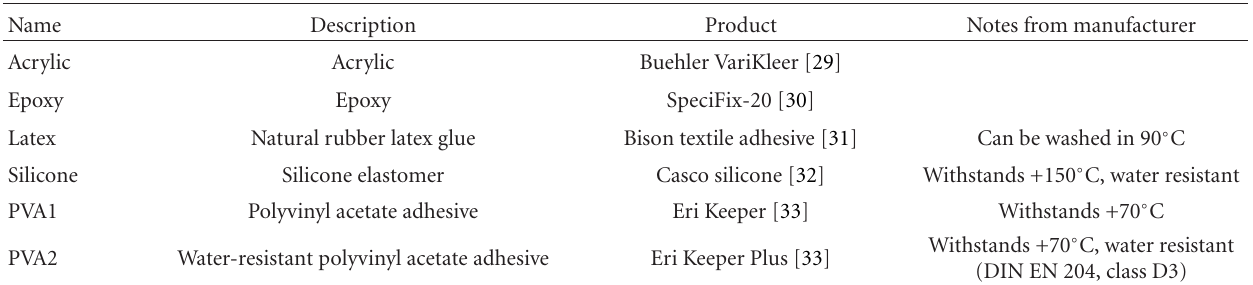
Table 2: Coating materials used in this